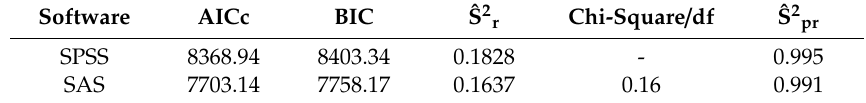
Figure 4. Model predicted averages for fluid velocity (cm / s) with 95% confidence intervals according to liquid level in the tank ( a ), internal pressure ( b ), and the number of active nozzles ( c ), in SPSS and SAS. Table 7. Best model information criterion AICc and BIC, ˆS 2 r : estimation of the residual variance, Chi-square value / degrees of freedom, ˆS 2 pr : estimation of the Pearson residual variance.